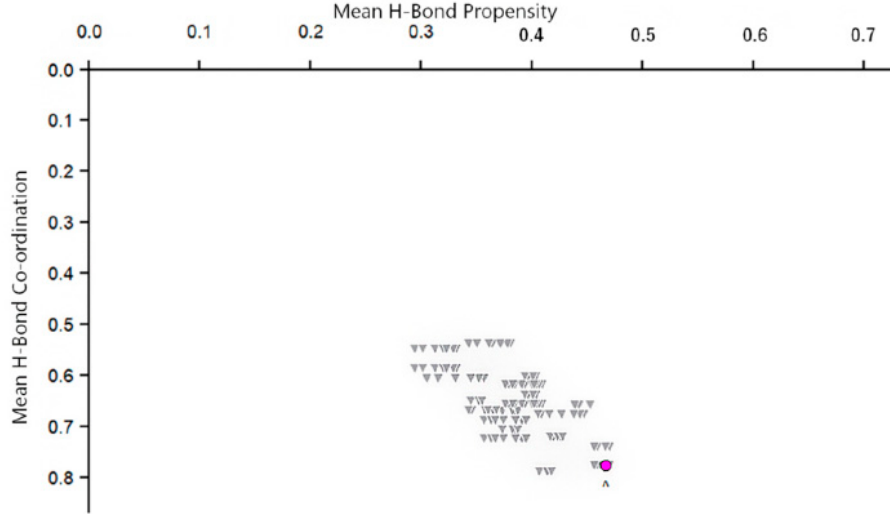
Figure 11. The propensity participation chart output showing form II (violet dot), which is found at the location with the optimal conditions (large values for both axes) that are usually associated with thermodynamically stable crystal forms.